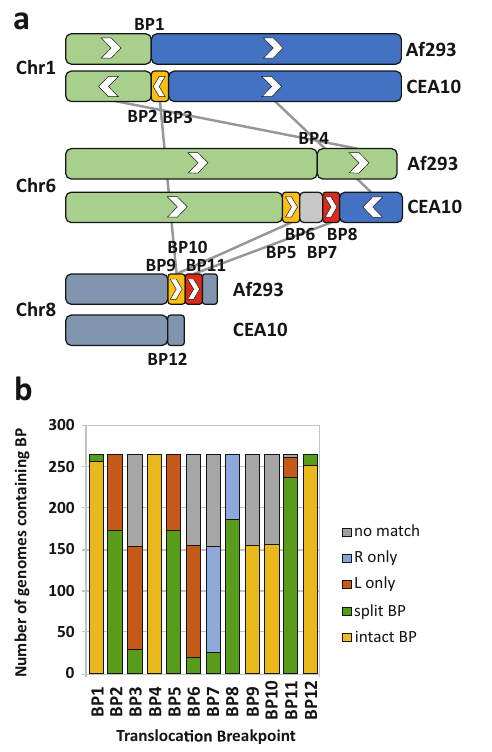
Fig. 6 | Conservation of translocation breakpoints in other A. fumigatus gen- omes. Translocation breakpoints found in the CEA10:Af293 comparison were mappedtootherpublished A.fumigatus genomesequences. a Breakpointsforeach translocationidenti fi edfromthegenomecomparisonarelabelledasBP. b Presence of translocation breakpoints in 261 A. fumigatus genome assemblies from NCBI. Graph represents the proportion of genomes in NCBI containing the various per- mutations of the translocation breakpoints identi fi ed in A. No match: neither left nor right breakpoint fl ank found in target genome. R only: only right breakpoint fl ank found in target genome. L only: only left breakpoint fl ank found in target genome. Split BP: both right and left breakpoint fl anks found in target genome at separate locations. Intact BP: breakpoint and fl anking regions found in the target genome. Chr –